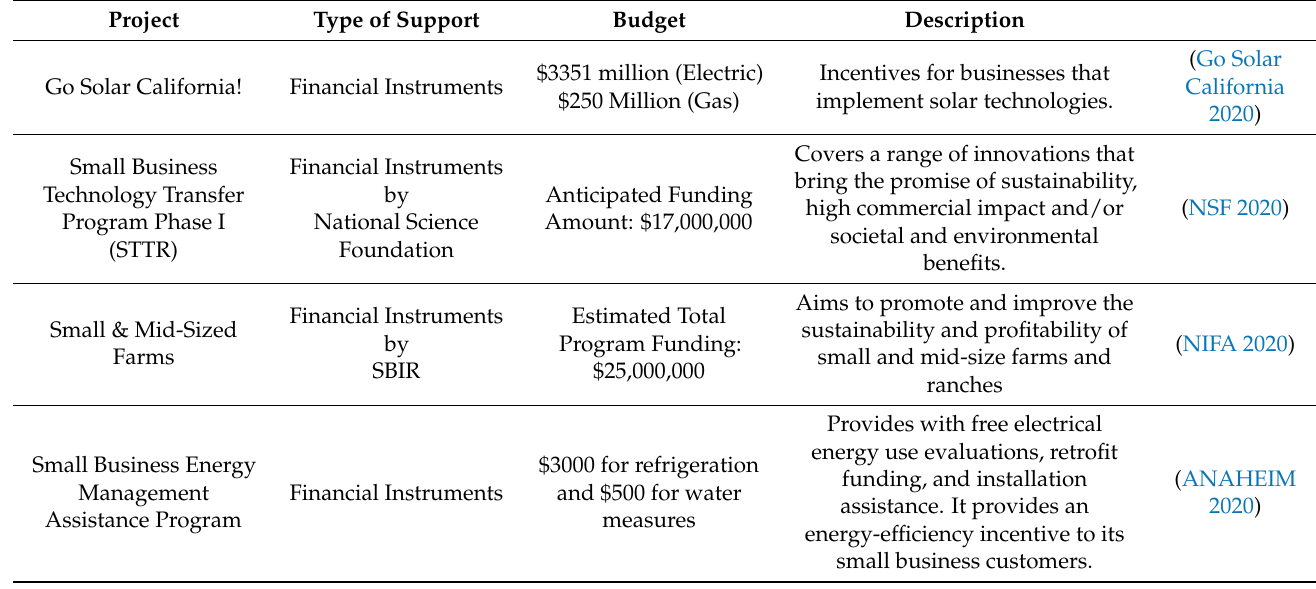
Table 6. Examples of responsible financing projects in the United States of